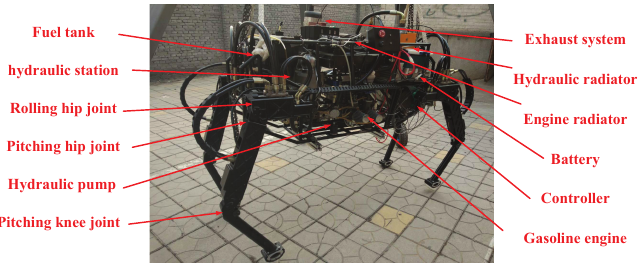
Figure 1. The overall structure of the SCalf robot.